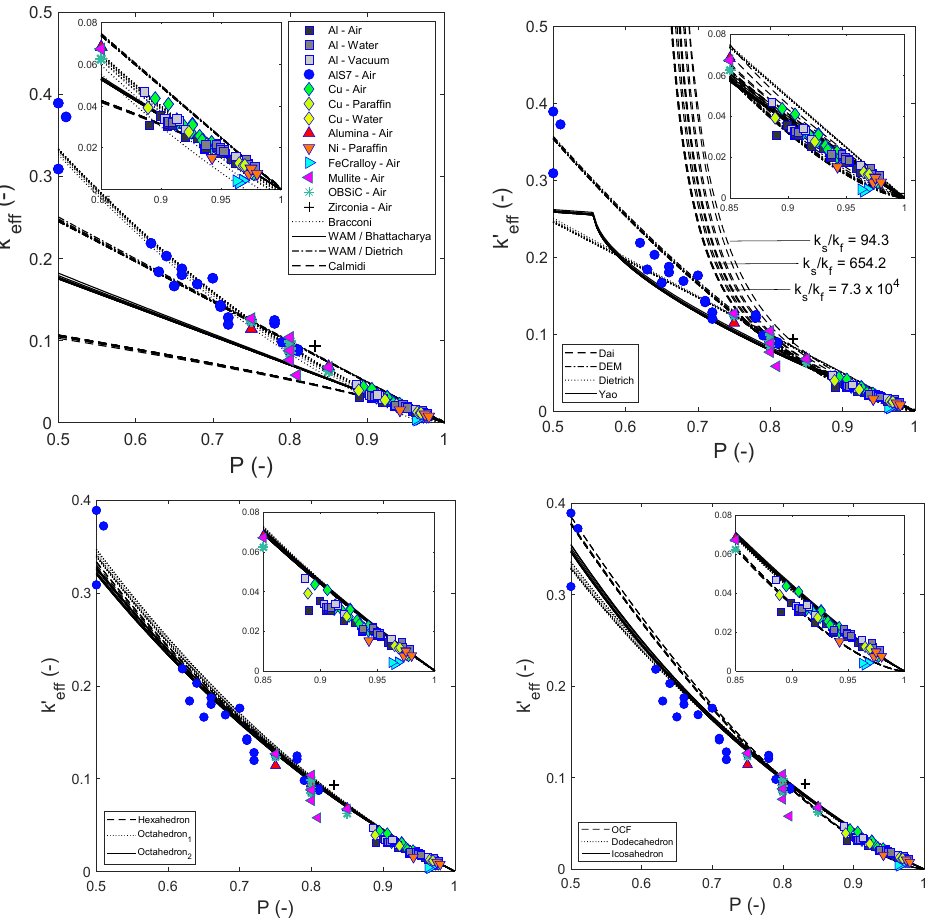
Figure 1. Normalized experimental 𝑘′ (cid:2915)(cid:2916)(cid:2916) values (represented by symbols corresponding to foams listed in Table 2) compared with those estimated from relations (represented by lines corresponding to relations listed in Table 1 and Equations (1) and (4)). The embedded subplots provide an enlarged view for the porosity ranging from 0.85 to 1.0. Table 4. Comparison of the RMSE for 𝑘 (cid:2915)(cid:2916)(cid:2916)(cid:4593) of the considered relations (* weighted arithmetic mean approach with corresponding arithmetic coefficient proposed by Bhattacharya or Dietrich; see remarks in Table 1). RMSE P ≥ 0.50 P ≥ 0.85 P ≥